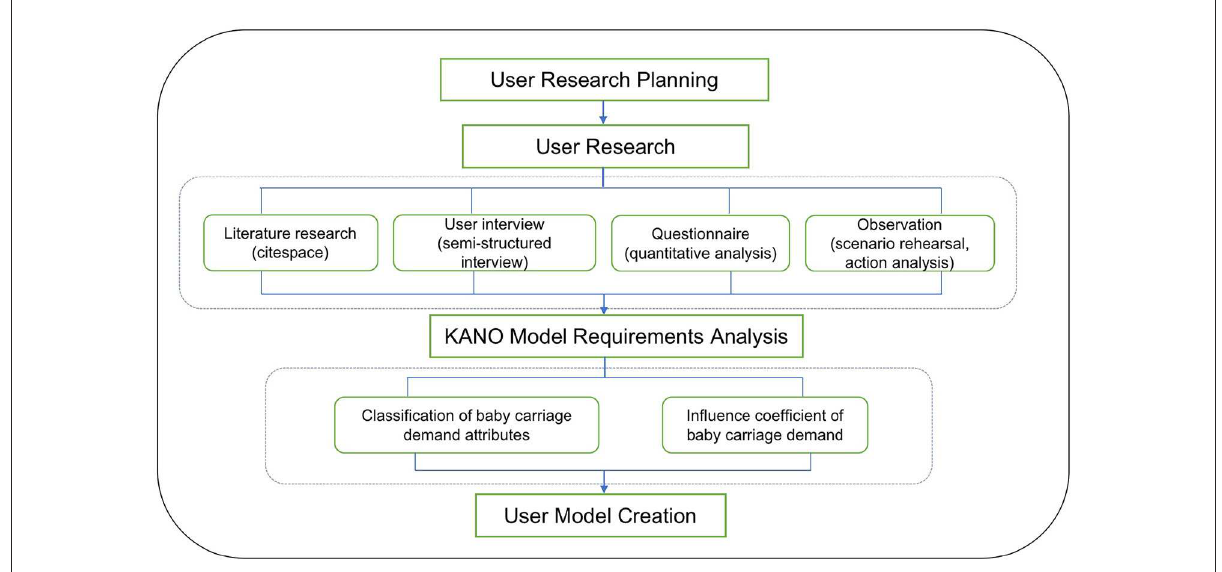
FIGURE2 Process of user research on the baby stroller